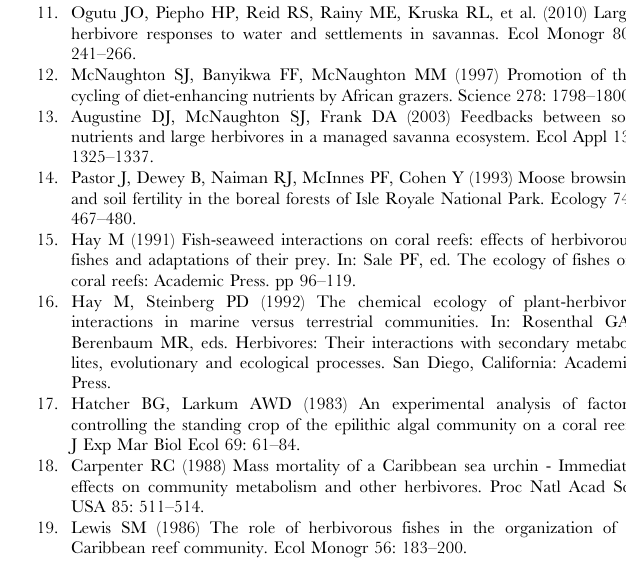
Table S4 ANOVA results on (a) biomass change and PERMANOVA results on changes in (b) nitrogen and (c) C/N of Lobophora variegata transplanted specimens in lagoon and reef flat habitats over the three sites.